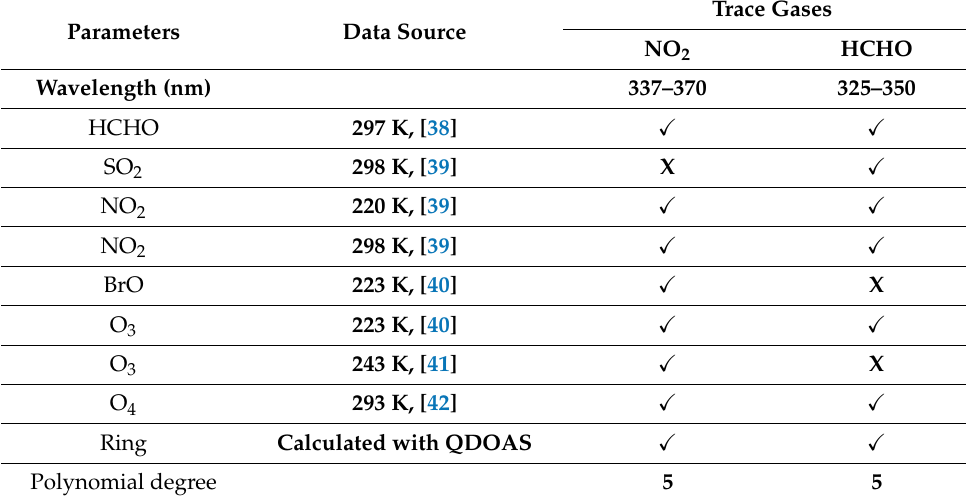
Table 1. Detailed settings for NO 2 and HCHO retrieval from differential optical absorption spec-